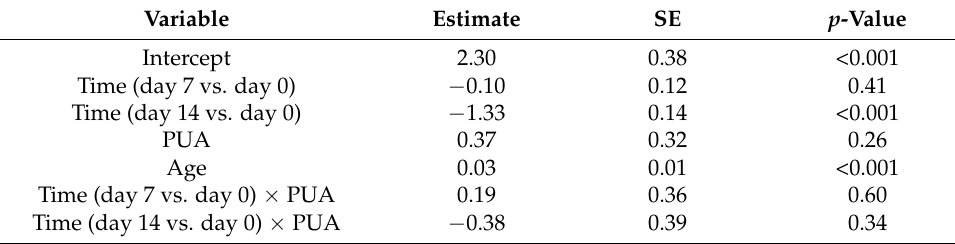
Table 4. Linear mixed models for WHO ordinal scale variation at day 7 and 14. Variable